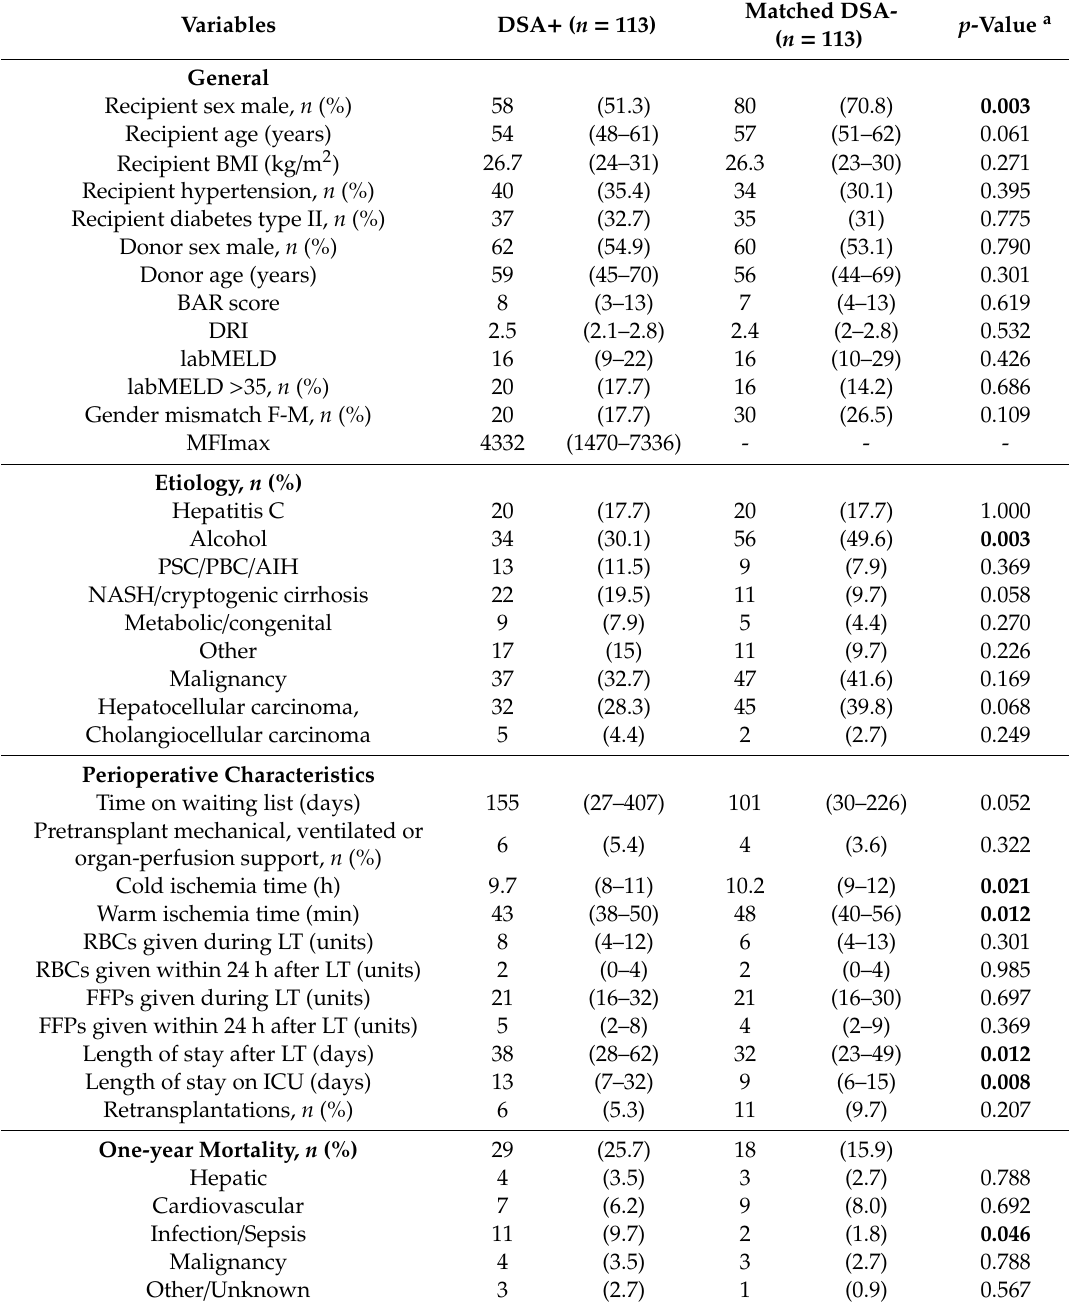
Table 2. Epidemiological, clinical, and operative data of patients who underwent LT from deceased donors between 1 January 2008 and 31 December 2015 sorted by DSA-positive (DSA + ) versus matched DSA-negative recipients (matched